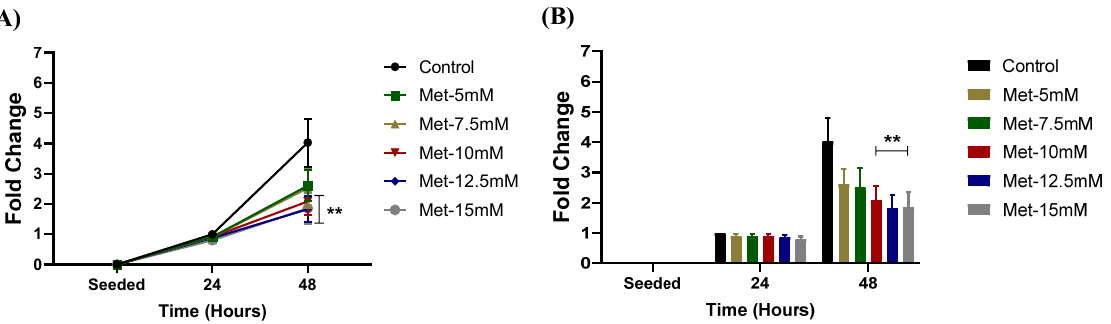
Figure 1. Proliferation of Lewis lung carcinoma cells following metformin treatment over 48 h. ( A , B ) Fold change (relative to control) in proliferating Lewis lung carcinoma (LL/2) cells treated with 5 mM, 7.5 mM, 10 mM, 12.5 mM, or 15 mM metformin for 24 and 48 h. Data were analyzed using a two-way ANOVA followed by Tukey’s multiple comparison test. ** p < 0.01 vs. Con (n = 5). Data are mean ± SEM.